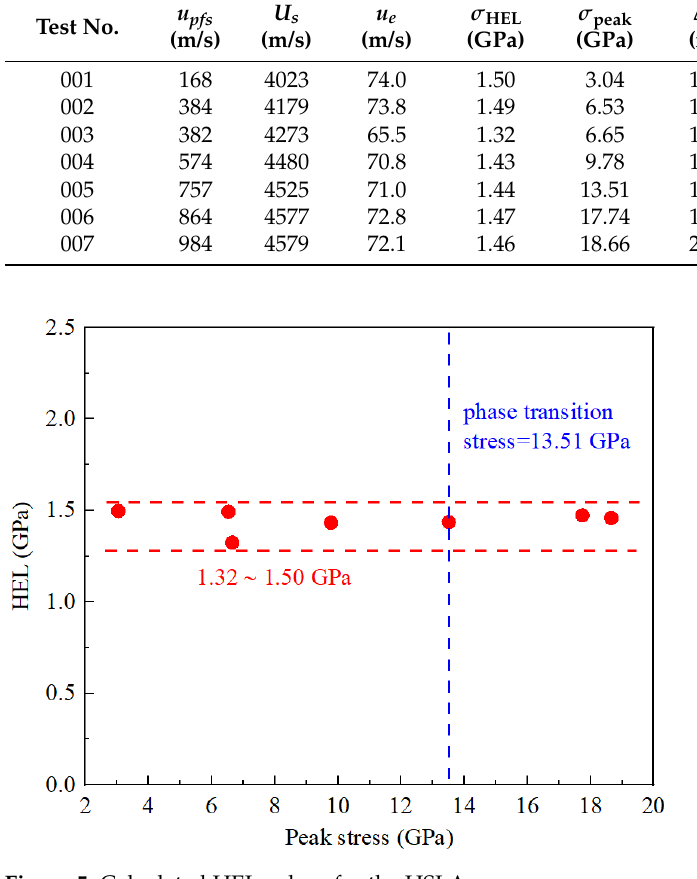
Figure 5. Calculated HEL values for the HSLA. Table 3. Experimental results for the HSLA obtained by plate impact test. Test No.